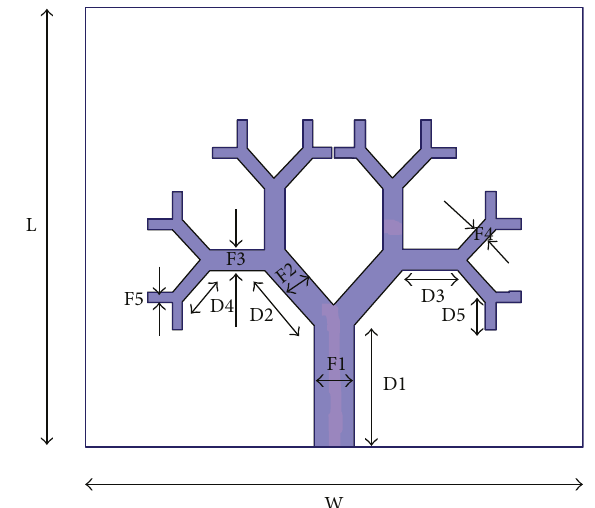
Figure 1: Photos of fabricated antenna without and with chemical deposition.